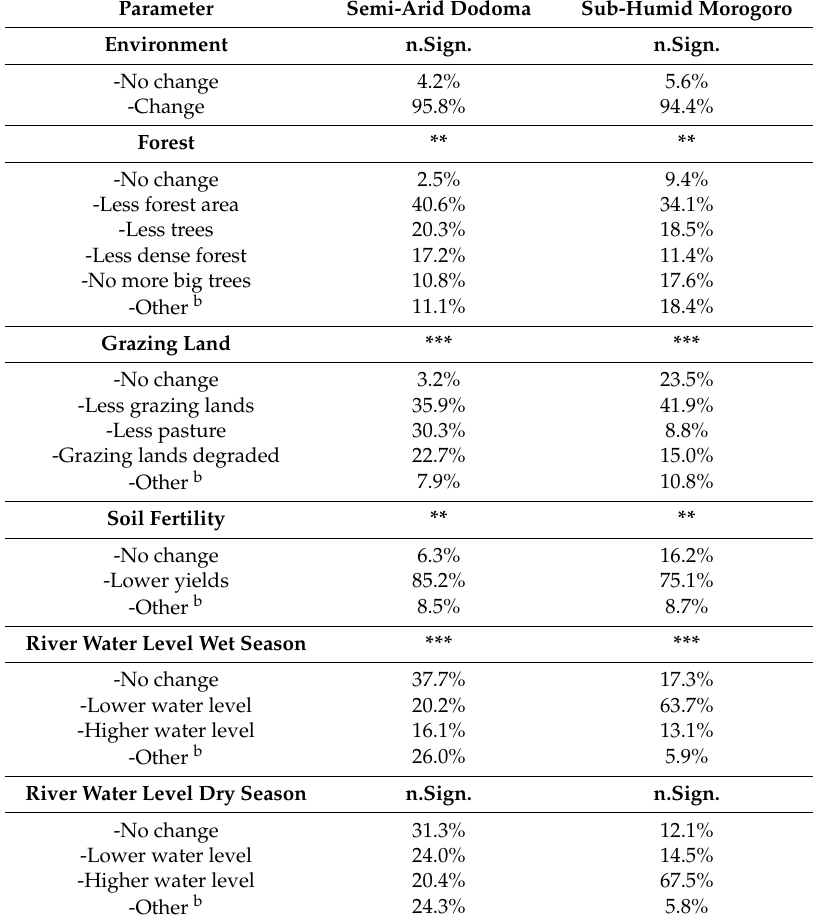
Table 2. Perceptions of environmental change in Dodoma and Morogoro (Mann–Whitney-U Test). Parameter Semi-Arid